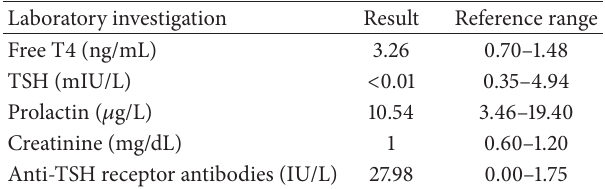
Table 1: Laboratory